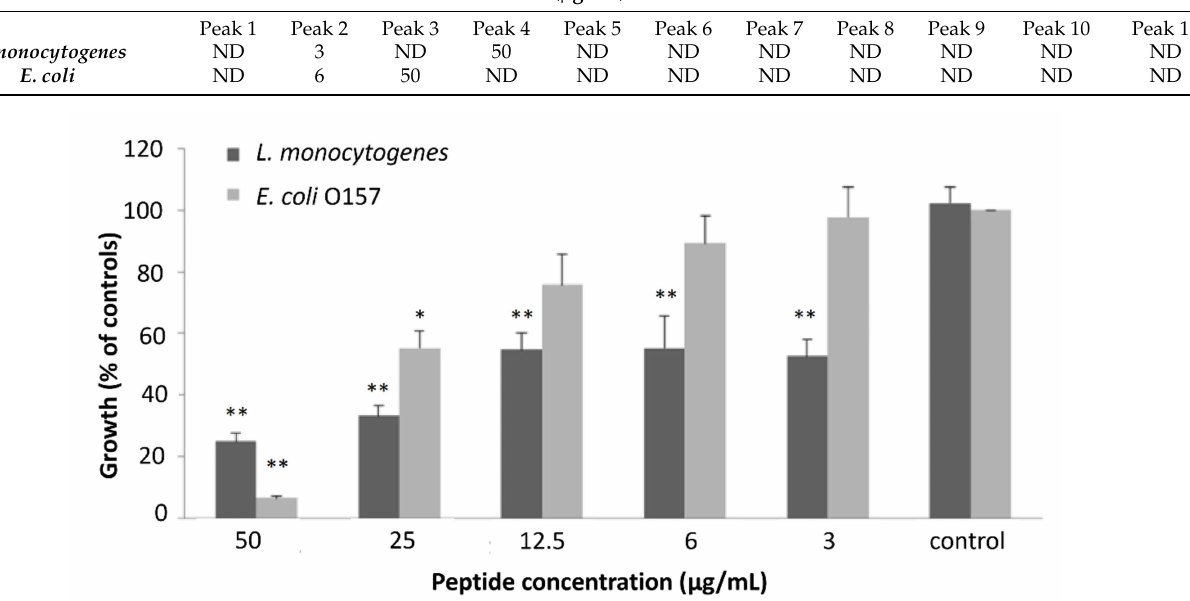
Figure 4. Dose–effect relationship showing inhibition of L. monocytogenes and E. coli O157 growth induced by different concentrations of HPLC-isolated peak 2. Bacterial growth in each strain is expressed as % of controls ± SD. ** p < 0.001, * p < 0.05.